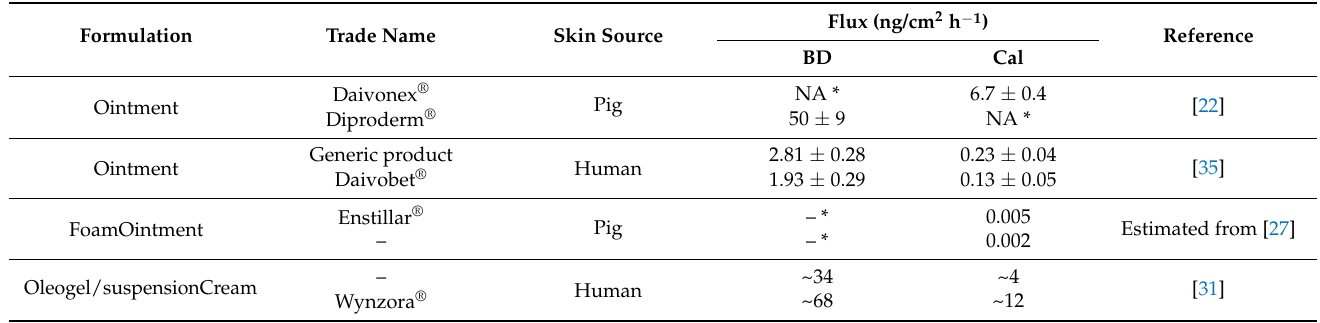
Table 1. Flux of BD and Cal from commercially available topical formulations determined through in vitro Franz diffusion cells. When the values were not tabulated, the flux is calculated as the slope of the permeation profile curve. NA: not